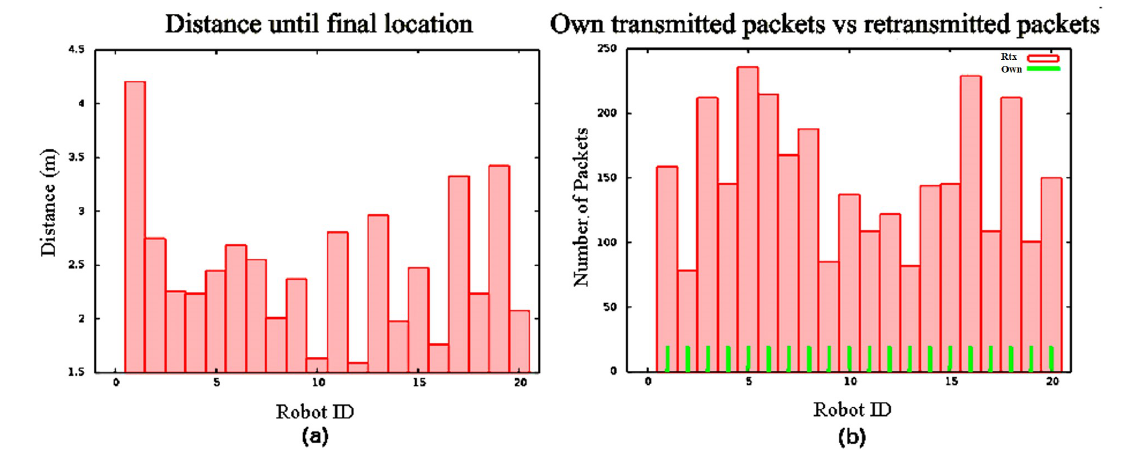
Figure 6. SPF deployment for 20 robots in an environment without obstacles: ( a ) d for every robot; ( b ) retransmission